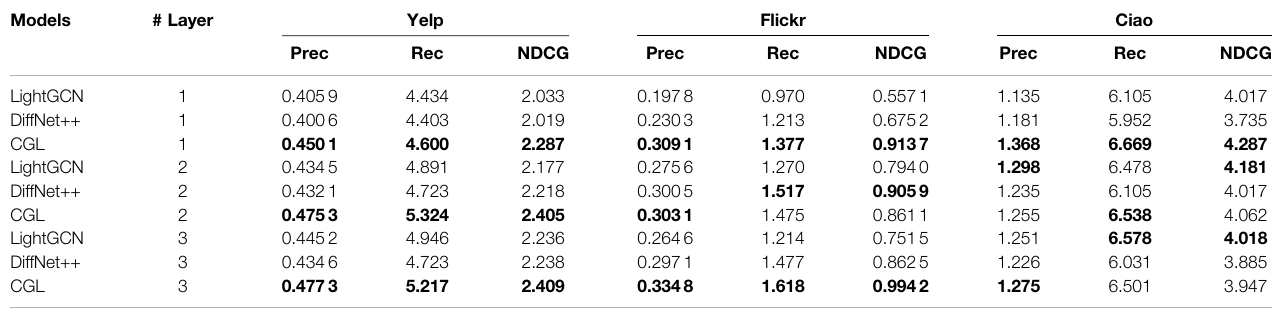
TABLE 5 | Comparison of CGL and two GNN-based baselines at each layer ( K = 20). The best results at each layer are in bold. Models # Layer